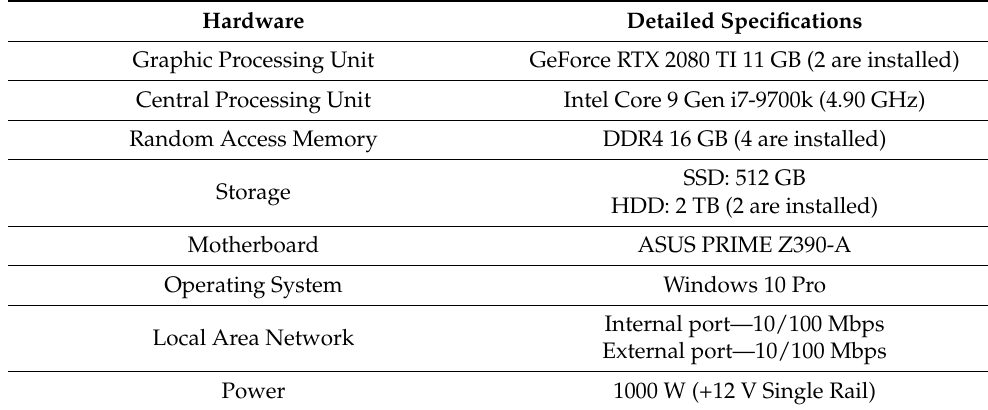
Table 5. Specifications of the hardware